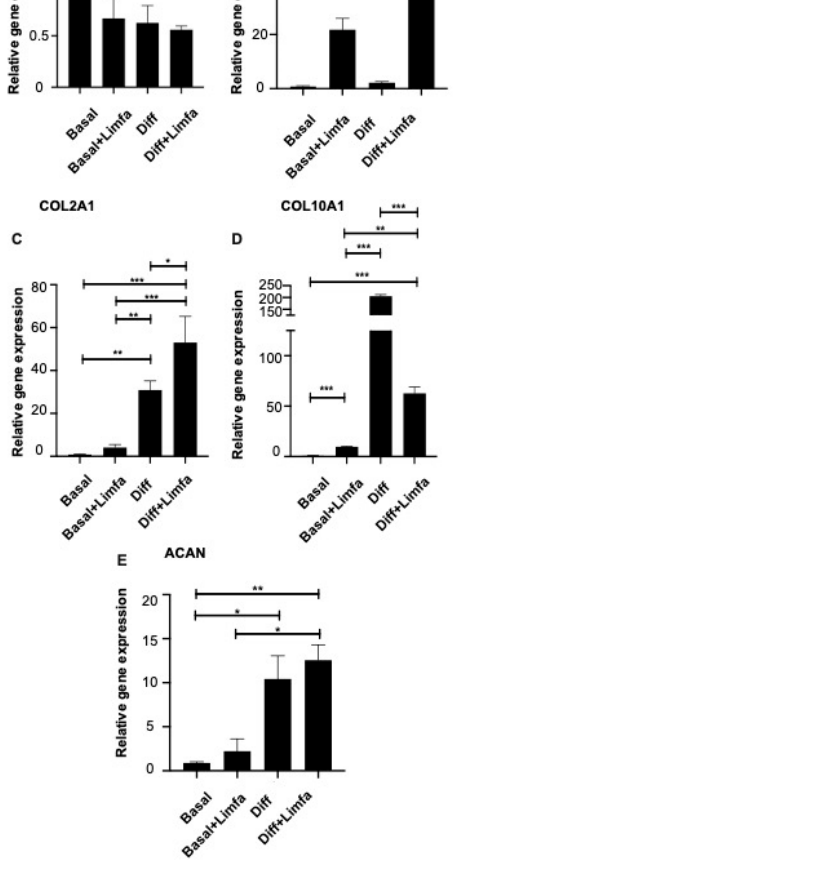
Figure 2. Expression analysis of the main chondrogenic differentiation markers in different cul- ture and treatment conditions. Cells were examined under different conditions. Basal, which corresponds to cells cultured in basal adipose stem cells medium; Basal + Limfa, which corresponds to cells cultured in basal adipose stem cells medium and treated with Limfa®Therapy; Diff, which corresponds to cells cultured in chondrogenic differentiation medium; Diff + Limfa, which corre- sponds to cells cultured in chondrogenic differentiation medium and treatment with Limfa®Therapy. SOX9 ( A ), RUNX2 ( B ), COL2A1 ( C ), COL10A1 ( D ) and ACAN ( E ) expression levels were assessed by RT-qPCR. Experiments are means of three different repeats. Results are expressed as relative gene expression (2- ∆ Ct) normalized on Basal culture conditions values. Error standard is reported. * = p < 0.05; ** = p < 0.025; *** = p < 0.01 (One-Way